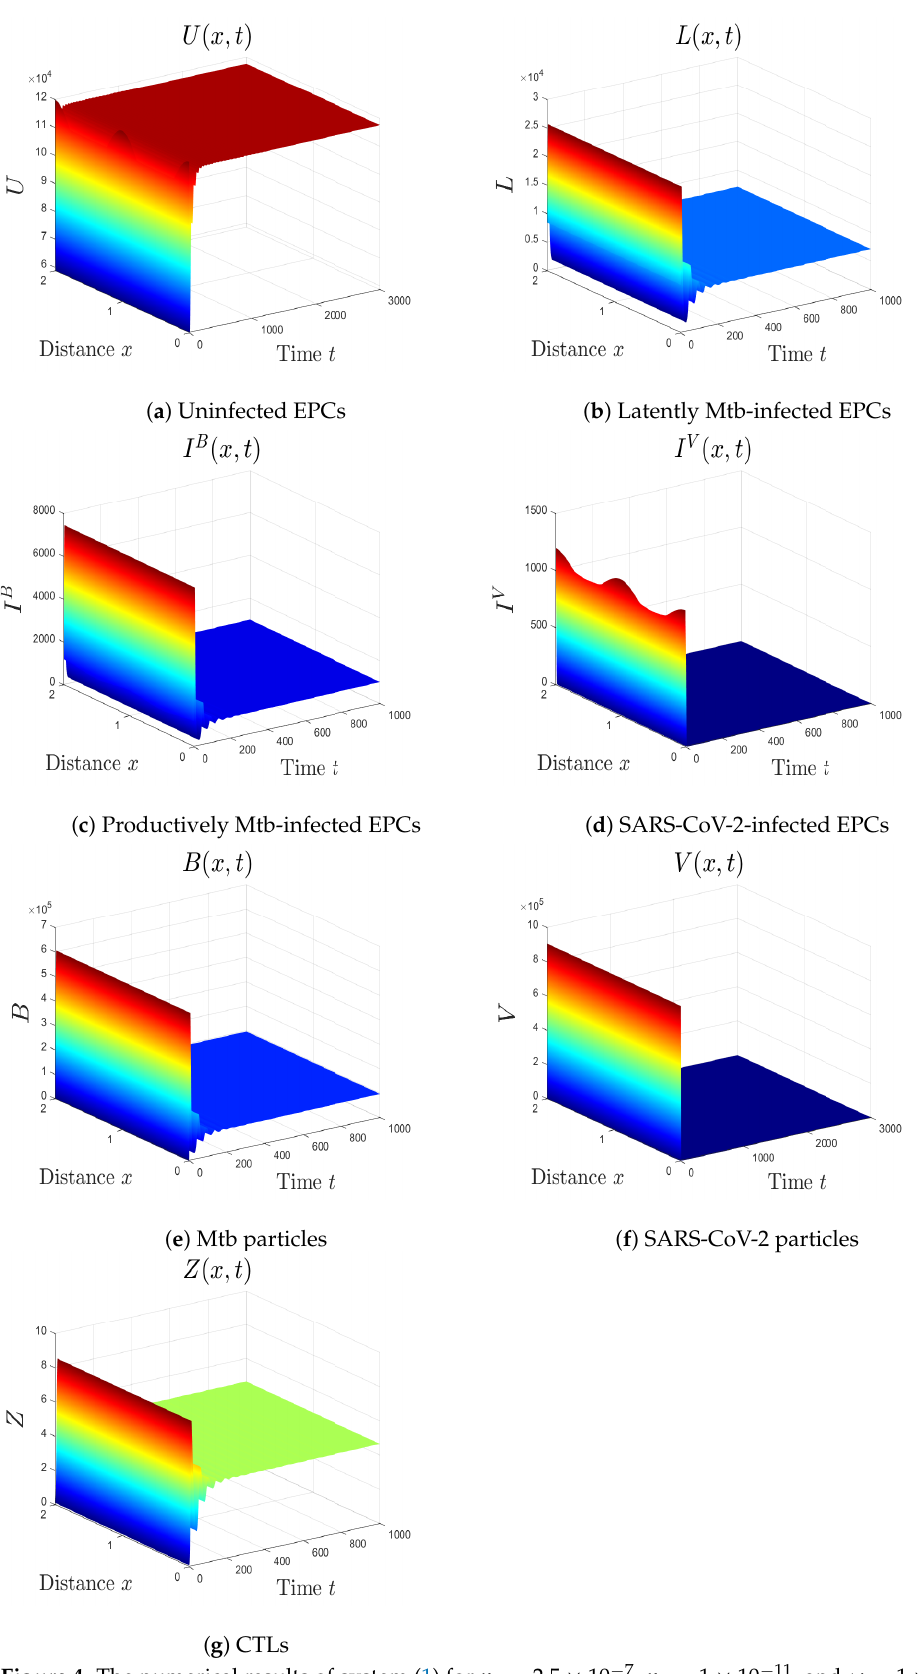
Figure 4. The numerical results of system (1) for η 1 = 2.5 × 10 − 7 , η 2 = 1 × 10 − 11 , and ω = 1 × 10 − 4 . The equilibrium E 3 = ( 117,514,7062.15,1000,0,96,153.8,0,4.64972 ) is